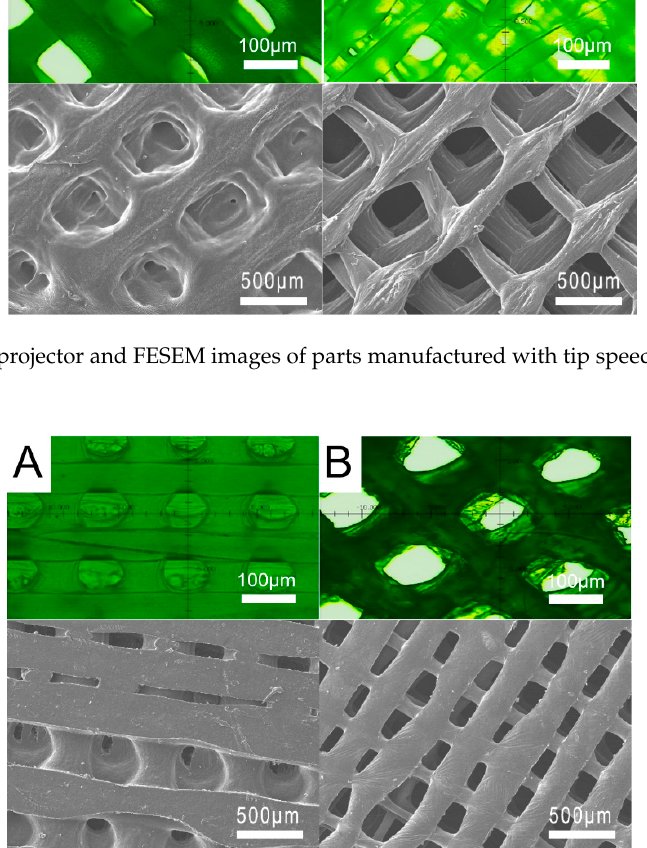
Figure 12. Profile projector and FESEM images of parts manufactured with orientations of ( A ) 90°, ( B ) 45°.